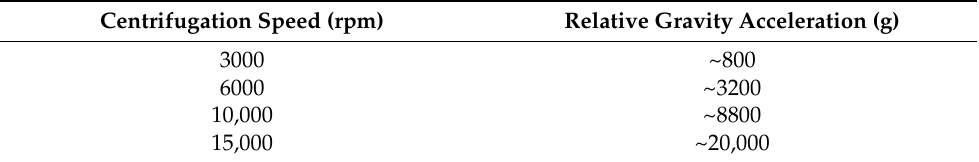
Table 1. Centrifugation speed and the corresponding relative gravity